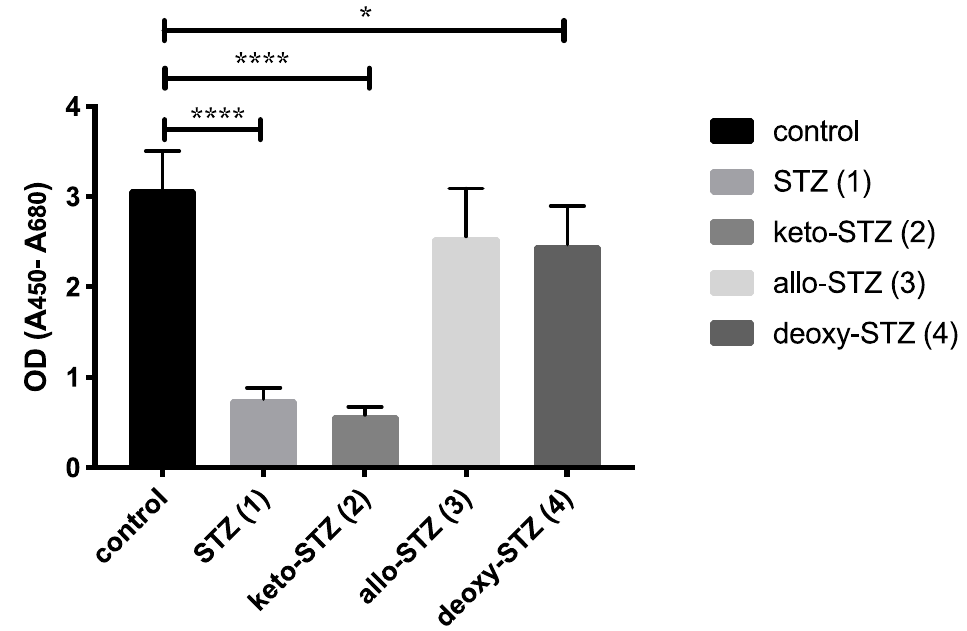
Figure 4. E ff ect of compounds 1 – 4 (5 mM) on viability of β cells. Significant di ff erences compared to Figure 4. Effect of compounds 1–4 (5 mM) on viability of β cells. Significant differences compared to the control were indicated by * p < 0.05 or **** p < the control were indicated by * p < 0.05 or **** p < 0.0001.